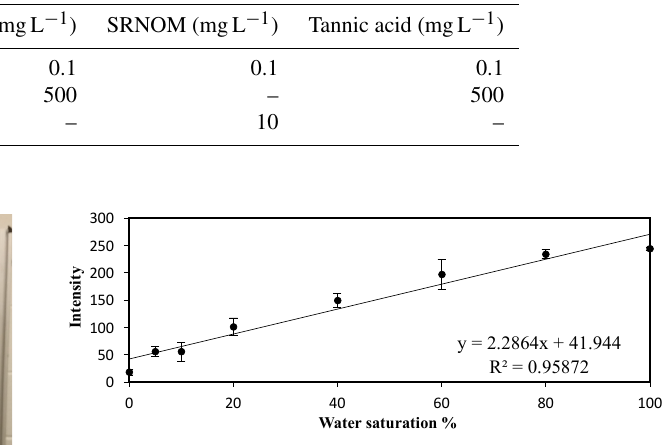
Figure 3. Empirical calibration curve of the transmitted intensity vs. the water saturation, with its linear trend line and slope equation.